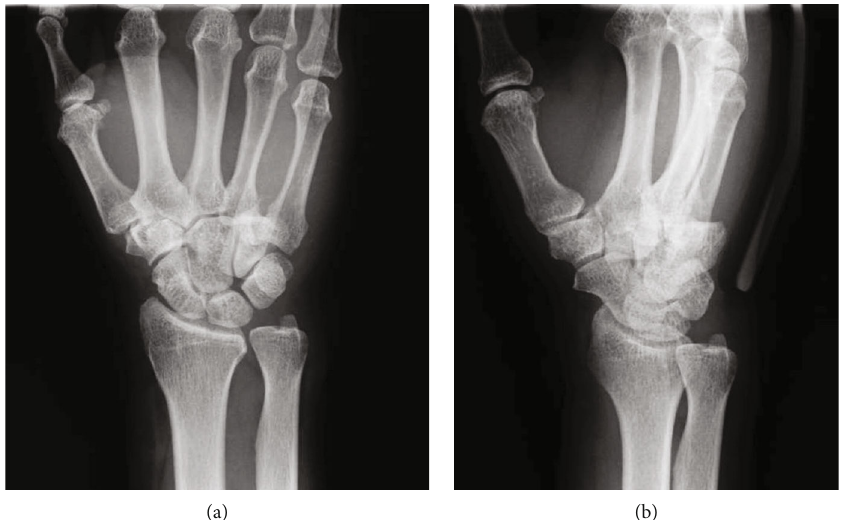
Figure 1: Initial radiograph showing the proximal displacement of the fourth and fi fth metacarpal bones. (a) Posteroanterior view. (b) Oblique semisupinated view.